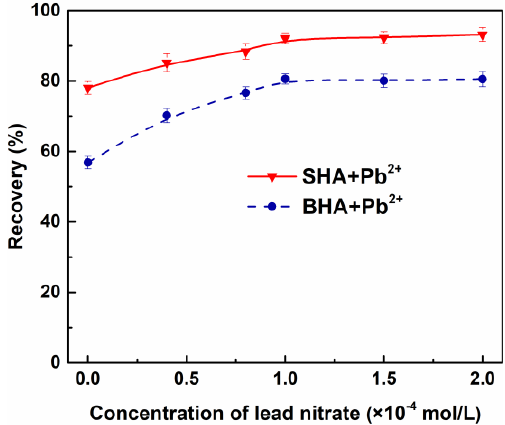
Figure 3. Effect of Pb 2+ concentration on ilmenite flotation recovery using SHA and BHA (C (BHA) = 2 × 10 −4 M, C (SHA) = 2 × 10 −4 M, pH = 6.0).